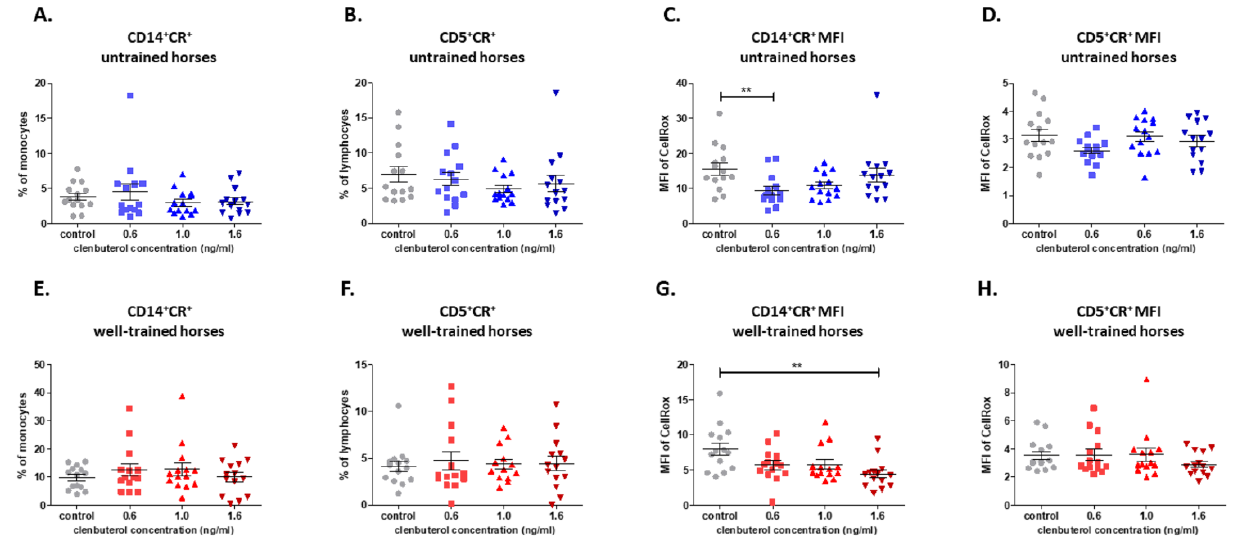
Figure 4. Graphic representation showing percentages of positive cells: CD14+CR+ ( A , E ), CD5+CR+ ( B , F ) gated from total lymphocytes/monocytes and median fluorescent intensity of CR (CellRox) in CD14+ ( C , G ) and CD5+ ( D , H ) cells. Each dot represents one individual horse ( n = 28) and means ± SEM (standard error of the mean) are presented. Significance levels are: ** p < 0.01.